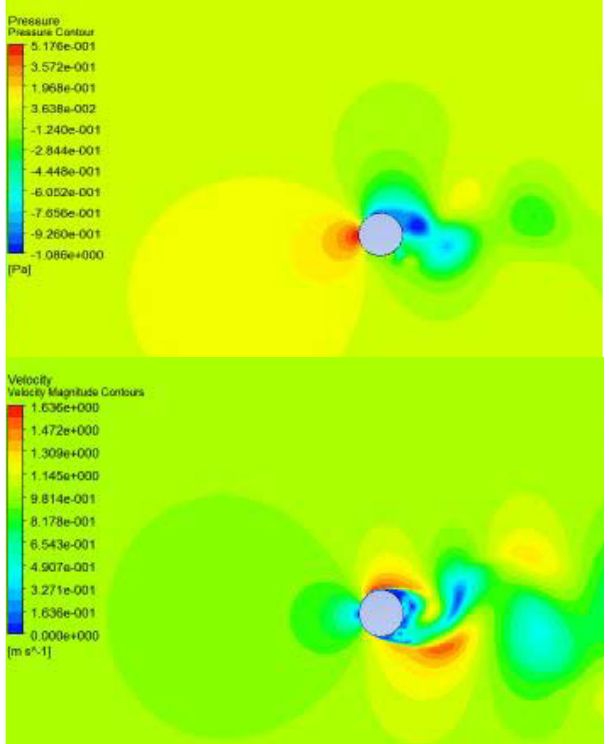
Fig.6. Pressure, velocity contours for circle section of cable for Re=25000